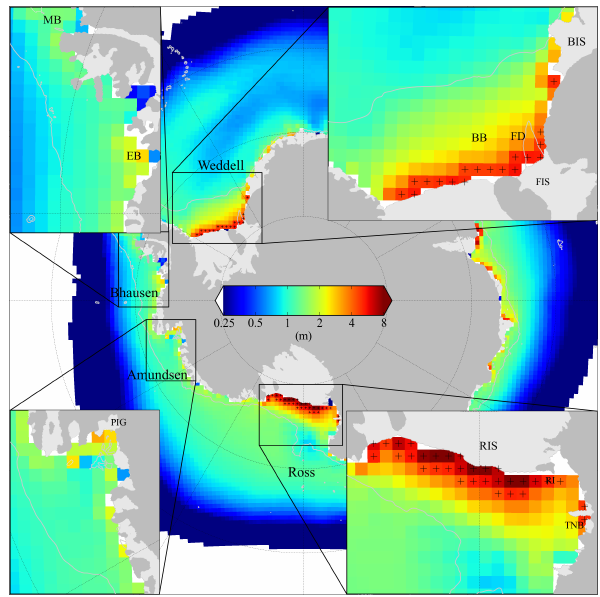
Fig. 14. Mean (1985–2011) annual ice growth. Crosses mark the grid cells where the mean annual ice growth is greater than 4m. Note that a logarithmic (base 2) colour bar/scale is used. The white line is the 1000m isobath contour taken from the RTOPO data set (Timmermann et al., 2010). BB: Berkner Bank, FD: Filchner De- pression, FIS: Filchner Ice Shelf, BIS: Brunt Ice Shelf, MB: Mar- guerite Bay, EB: Eltanin Bay, PIG: Pine Island Glacier, RIS: Ross Ice Shelf, RI: Ross Island, MS: McMurdo Sound, TNB: Terra Nova